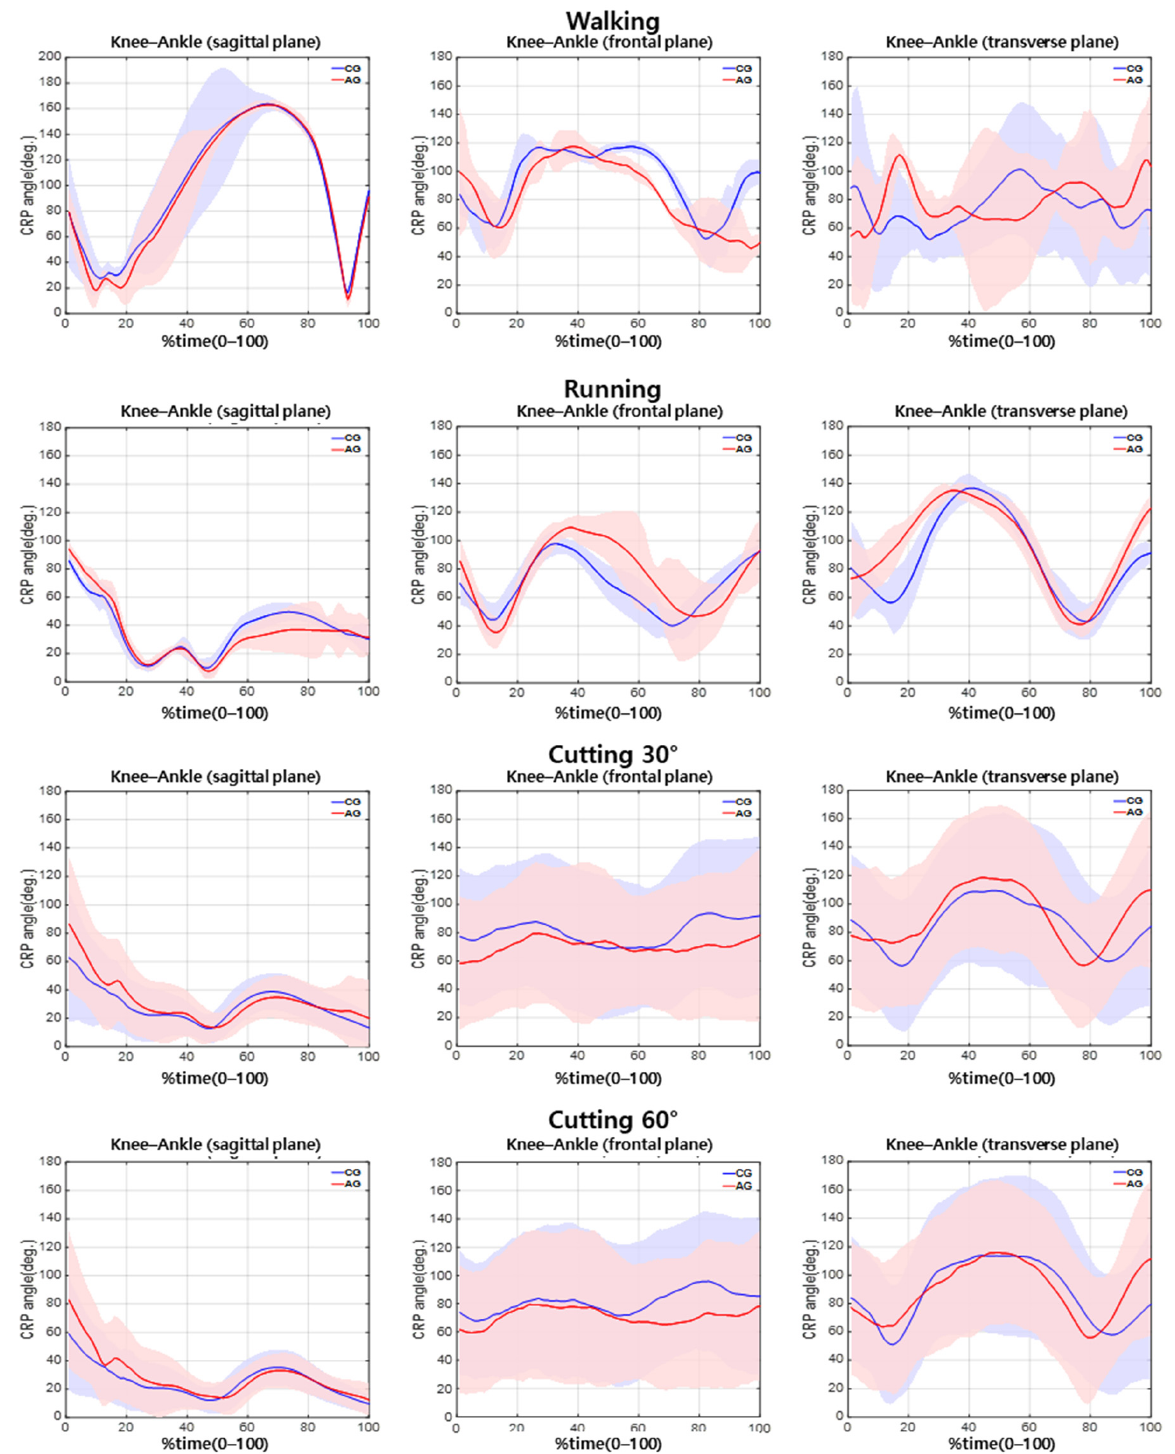
Figure 5. Ensemble average of CRP between knee–ankle joint according to difficulty of movement.